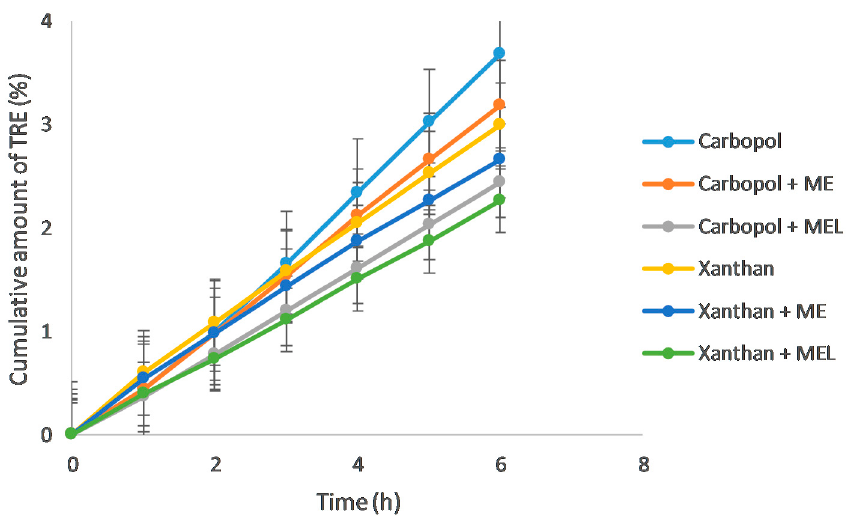
Figure 7. Ex vivo permeation of tretinoin from the reference gels, the gels containing the reference microemulsion (ME), or the gels containing the lecithin-containing microemulsion (ME L ) as drug solubilizers via pig´s ear skin ( n = 4).